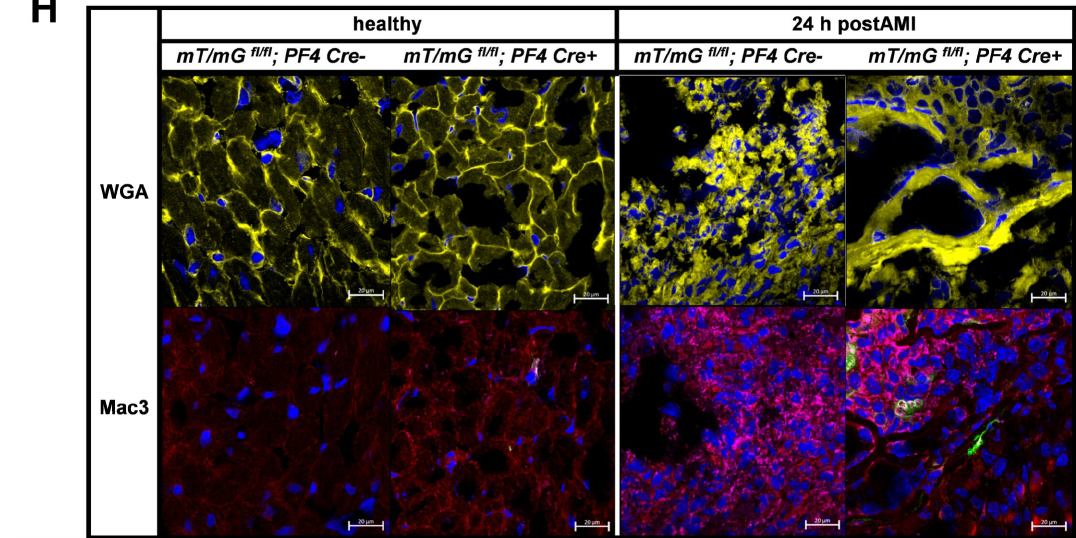
Figure 3. Platelet depletion leads to a reduced inflammatory response in the acute phase after myocardial infarction. ( A ) IL-1 β plasma levels and ( B ) activation of neutrophils in platelet depleted naive mice and 24 h post AMI compared to IgG injected control mice. n.d. = not detectable; n = 4–9 ( A ); n = 3–6 ( B ). ( C ) Number of total cells in the infarcted myocardium in IgG injected control and platelet depleted mice 24 h post AMI; n = 5. ( D , E ) Platelet-leukocyte and platelet-neutrophils aggregates in IgG injected control and platelet depleted mice before and 6 h to 72 h post AMI; n = 4–6. ( F , G ) Number of Mac-3 ( F ) and Ly6G ( G ) positive cells in the infarcted myocardium in IgG injected control and platelet depleted mice 24 h post AMI; n = 5. Quantification (left panel) and representative images (right panel). ( H ) WGA staining in yellow and Mac-3 staining in violet was performed to identify macrophages in the infarcted area of the left ventricle from naïve (left panel) mT/mG;PF4- Cre- or mT/mG;PF4-Cre+ mice and 24 h post AMI (right panel), respectively. Scale bar = 50 µ m. n = 3–4. In the utilized mouse model, platelets appear in green, whereas the remaining tissue (all other cells) shows red fluorescence. Data are presented as means ± SEM. Statistical analyses were done by Two-Way ANOVA followed by Sidak post hoc ( A – D ) or by two-tailed unpaired Student’s t -test ( E – G ). * p < 0.05, ** p < 0.01, *** p <